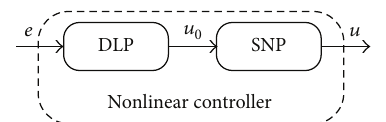
Figure 5: The scheme of the nonlinear controller.